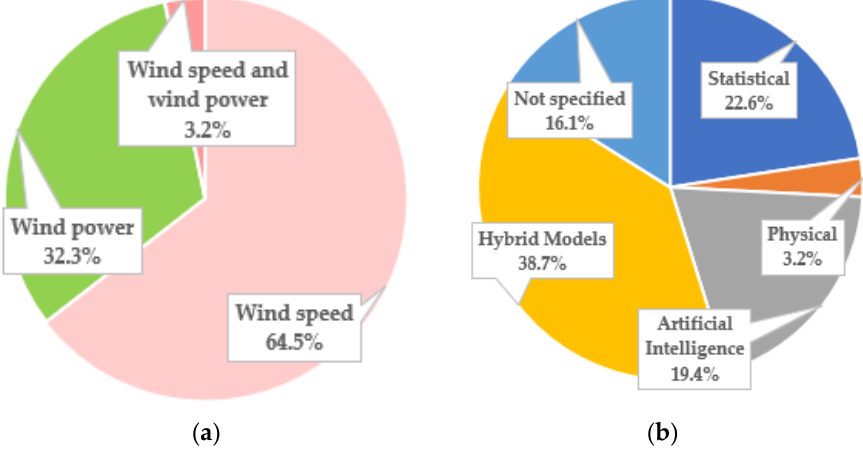
Figure 9. ( a ) Percentage distribution of the forecast objective of short-term models. ( b ) Percentage distribution of short-term forecasting methods.